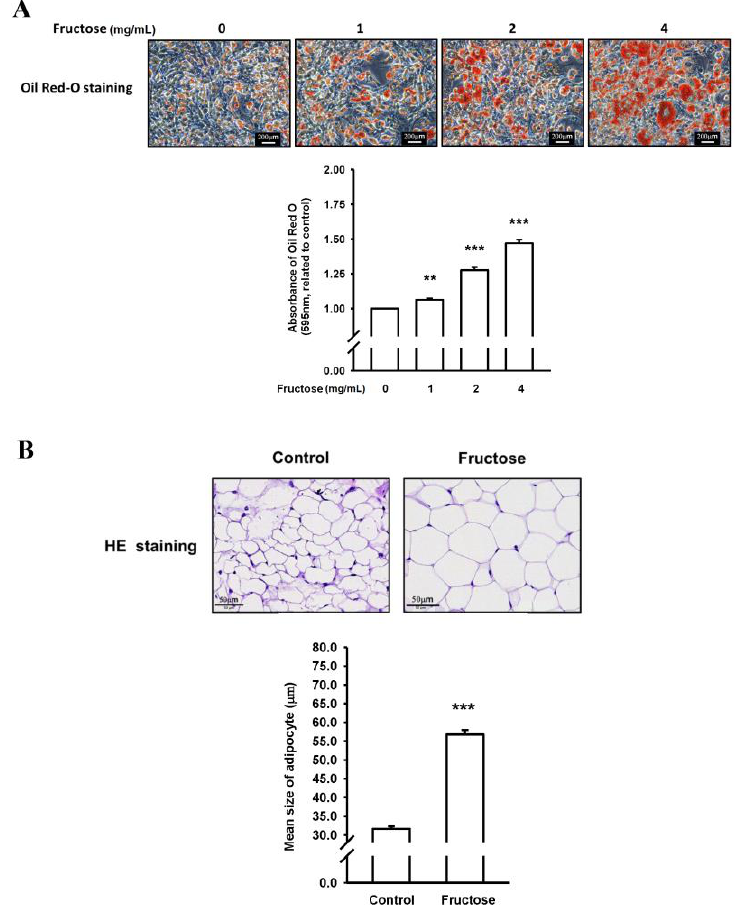
Figure 1. Effects of different fructose concentrations on ( A ) triglyceride levels by measuring Oil Red O (ORO) staining in adipocytes in vitro and ( B ) adipose size obtained from our previous study [17]. N = 6, the results from 6 independent experiments in cell culture experiments and from 6 mice in tissue used study. Values are presented as mean ± standard deviation (SD). **, and *** denote p < 0.01, and <0.001 vs. the control groups at Day 7 of the experimental protocol, respectively.